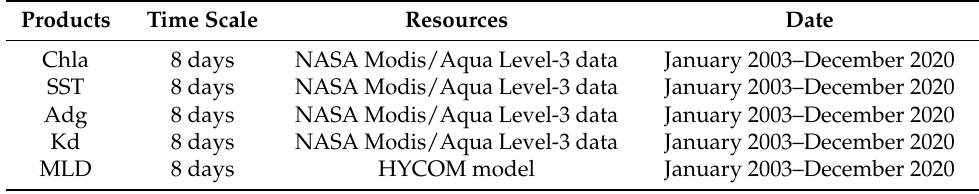
Table 1. Data source about remote sensing product in the model.